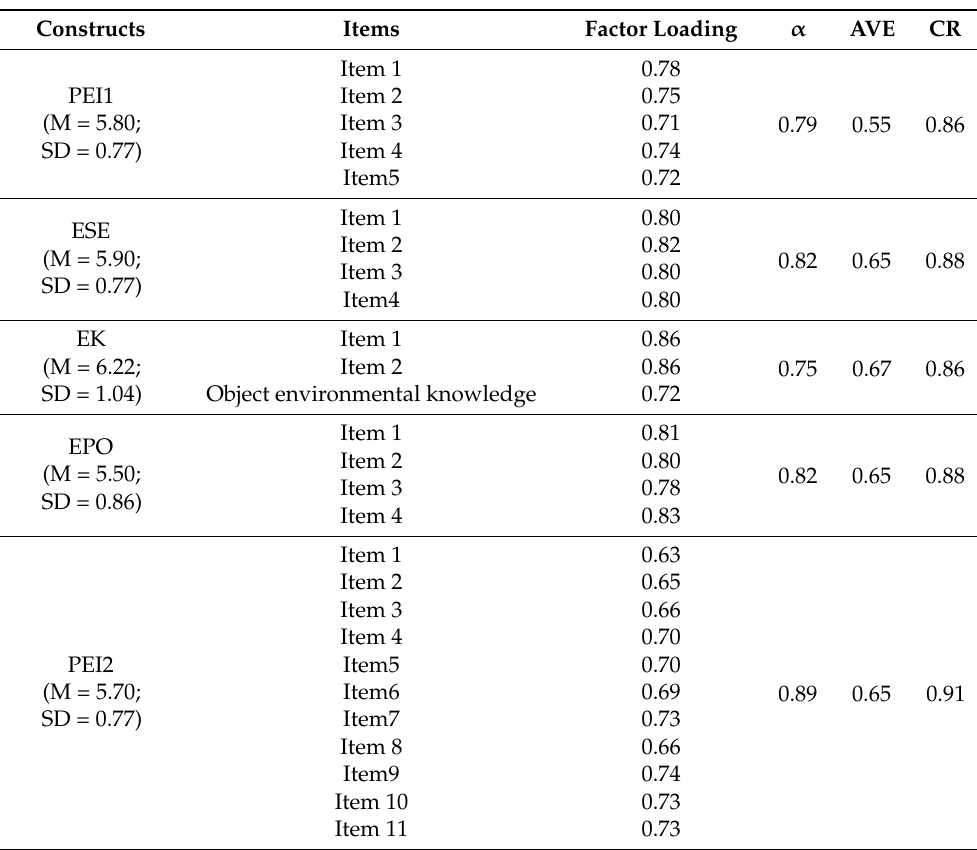
Table 2. Results of confirmatory factor